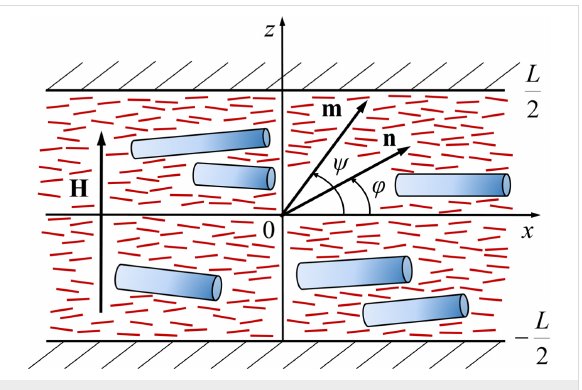
Figure 1: The planar layer of LC doped with CNTs in an external mag- netic field, choice of the coordinate system.